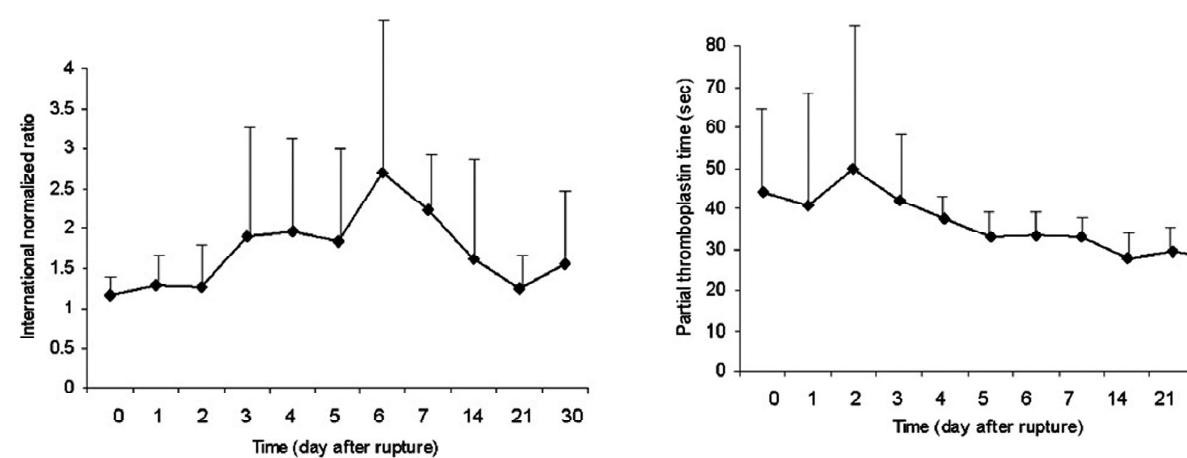
Fig. 3 - Kinetics of international normalized ratio after myocardial rupture